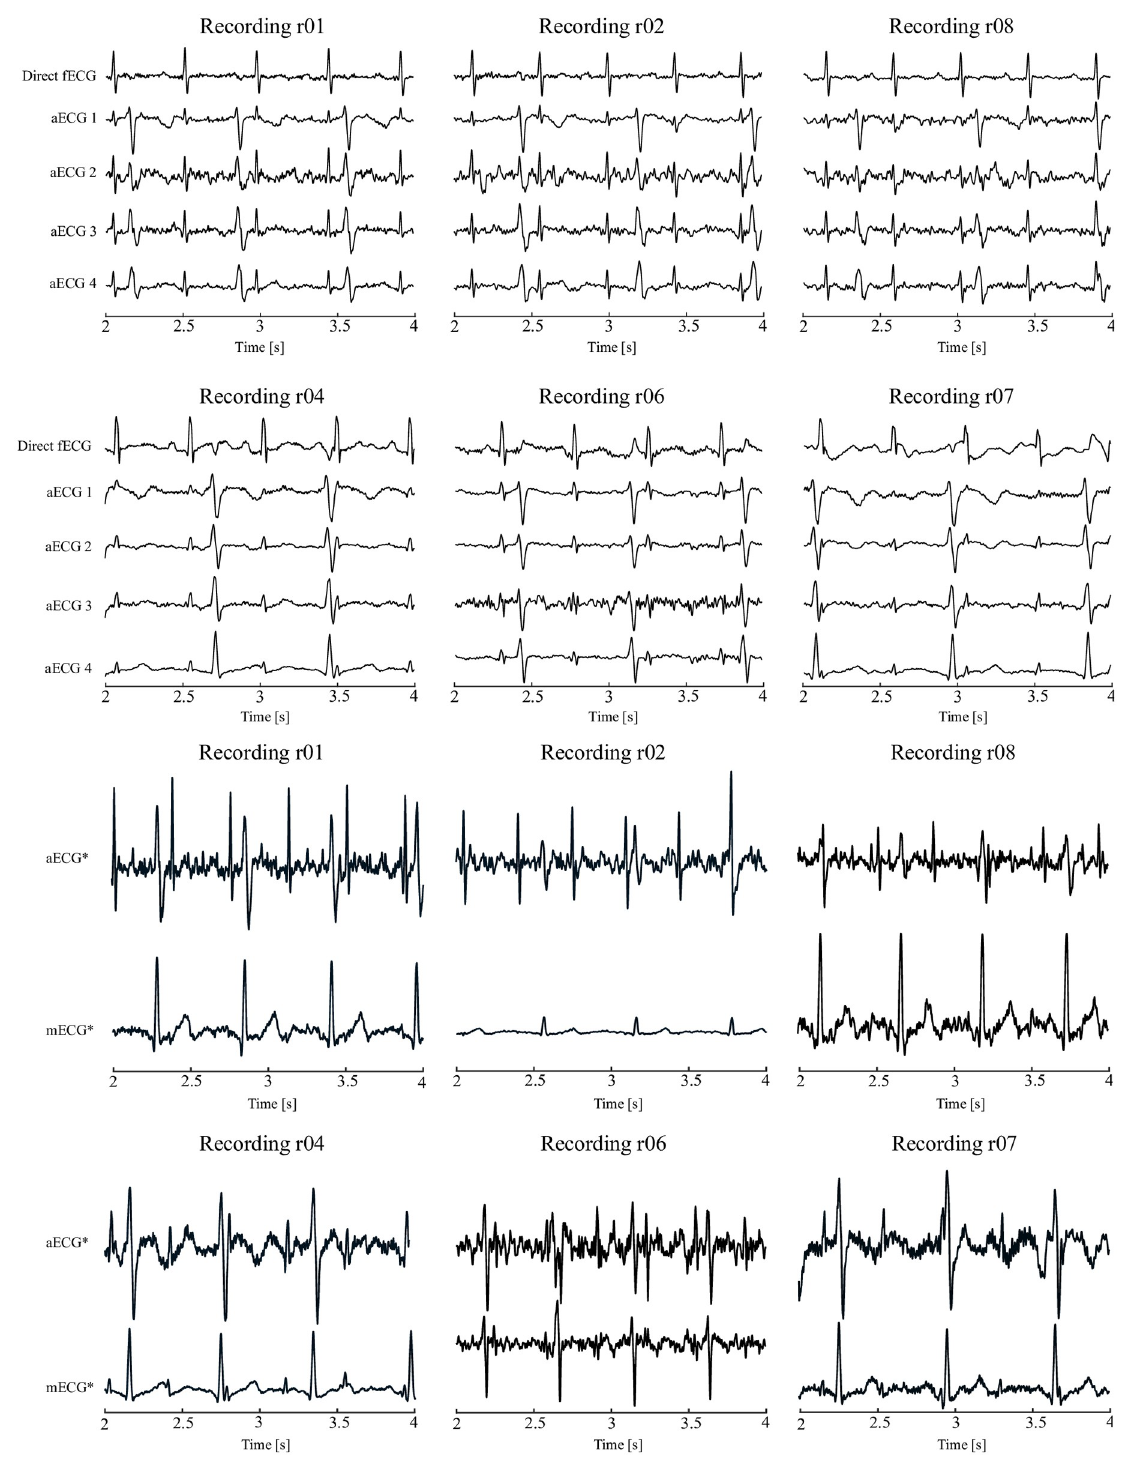
Fig 8. Examples of aECG signals from the ADFECGDB database. Three of high quality (r01, r02, r08) and three low quality (r04, r06, r07) along with corresponding aECG � and mECG � signals estimated using ICA.